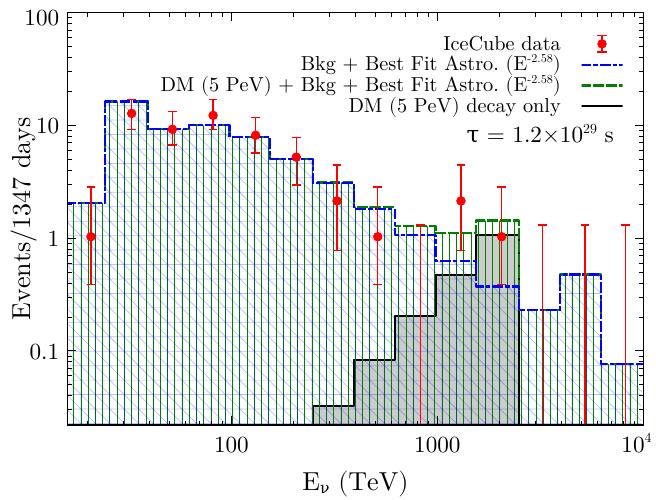
Figure 9 . Event distribution for 4-yr IceCube data with the contribution of decaying DM. Here we take mass of the DM to be 5 PeV with a lifetime of 1 : 2